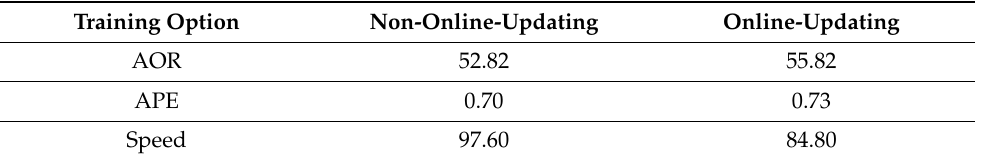
Table 4. AOR and APE, as well as speed of online-updating or non-online-updating, on the OTB2013 dataset.